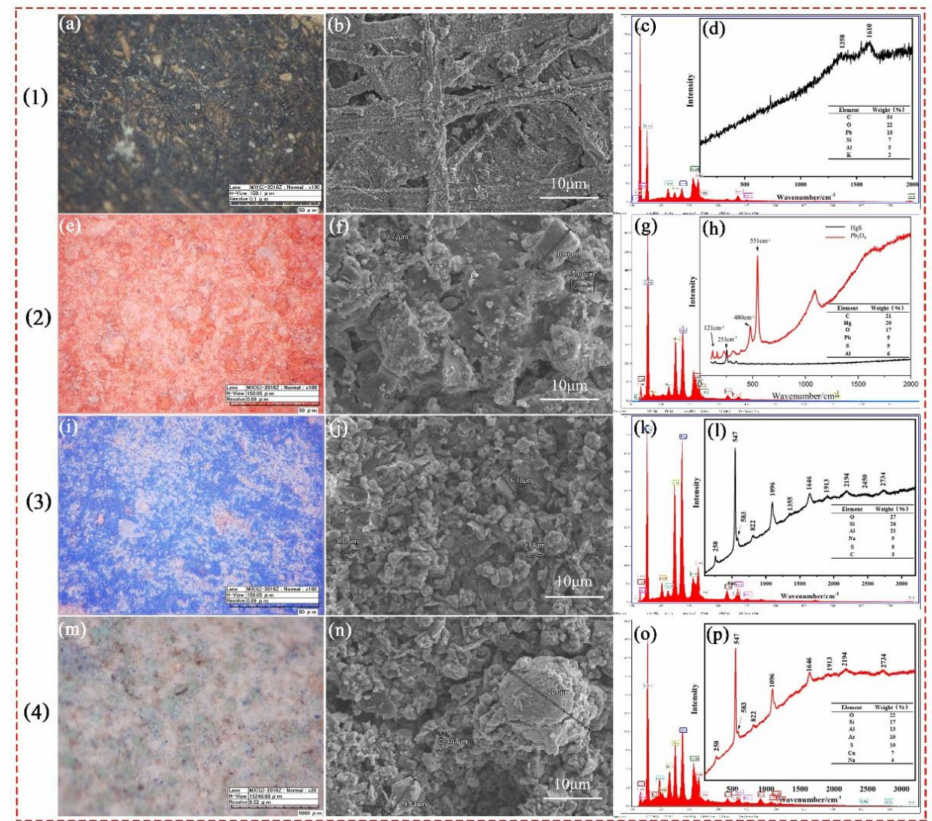
Figure 4. Macro- and micromorphology and elemental compositions of pigments. Macro-morphology ( a , e , i , m ), SEM ( b , f , j , n ), EDS ( c , g , k , o ) and Raman ( d , h , l , p ) of the Black (1), Red (2), Blue (3), Green (4)